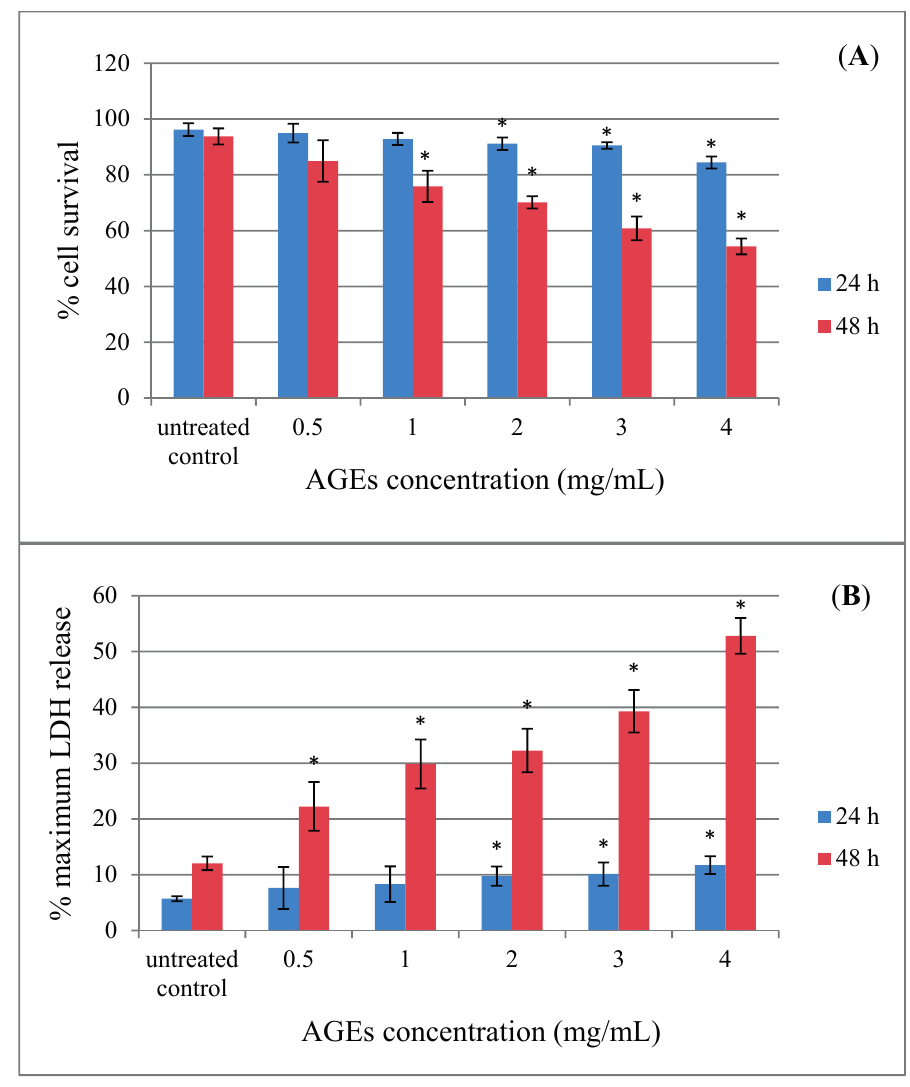
Figure 3. Advanced glycation end-products (AGEs) have an effect on the cell toxicity of SH-SY5Y cells. SH-SY5Y cells were incubated with different concentrations of AGEs (0–4 mg/mL) for 24–48 h. ( A ) The cell survival of living SH-SY5Y cells was assessed using the trypan blue exclusion assay. ( B ) The release of LDH of damaged SH-SY5Y cells was assessed using the LDH assay. Values are reported as the means with their standard error of the mean (SEM), depicted by vertical bars. All experiments were performed in triplicate (N = 3). * p < 0.05 for a significant change as compared to untreated control